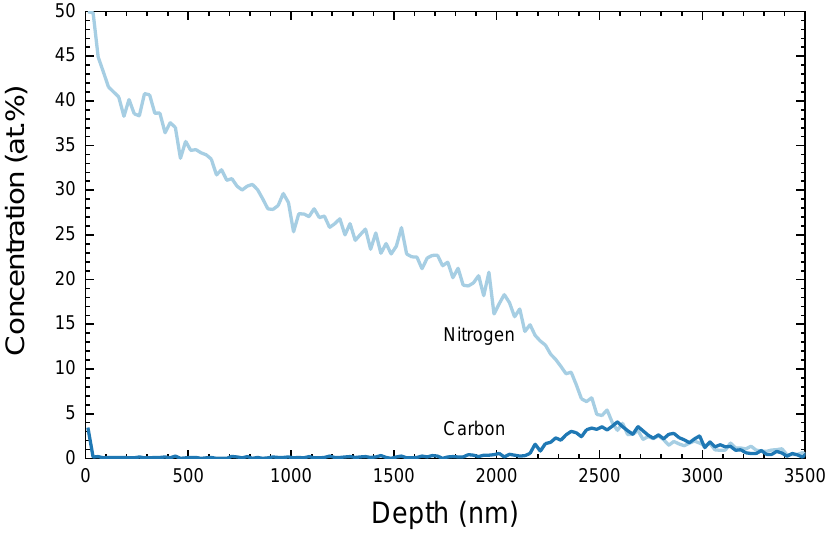
Figure 6. Nitrogen and carbon depth profile for the sample depicted in Figure 5 as obtained by secondary ion mass spectrometry (SIMS) and calibrated by glow discharge optical emission spectroscopy.